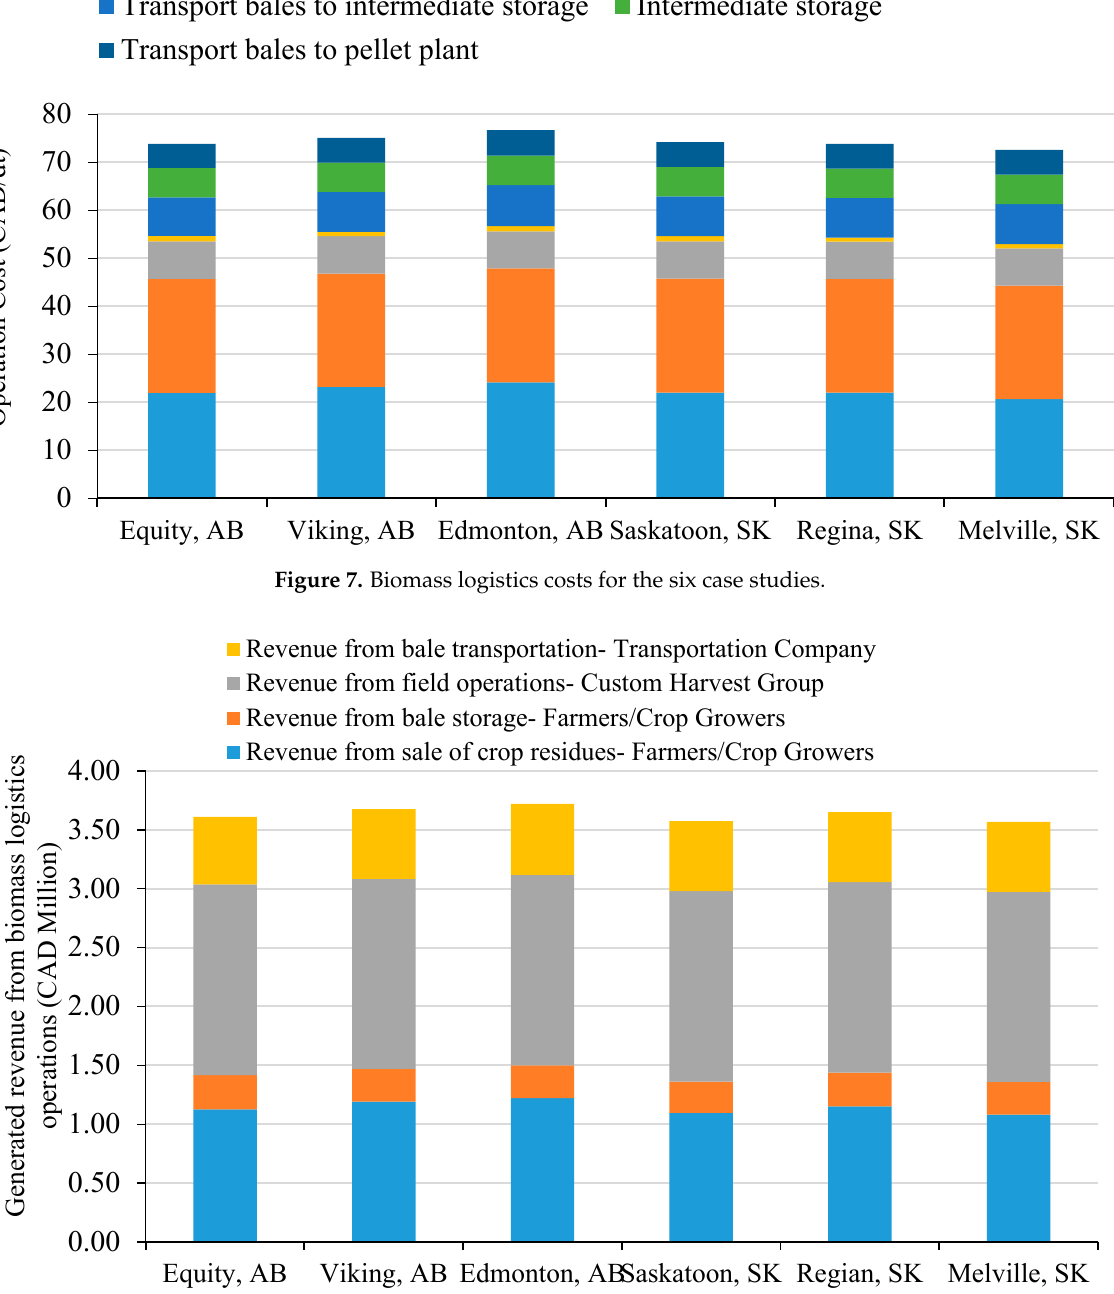
Figure 8. Annual revenue generated in the upstream biomass logistics system by supplying agricultural biomass for the pellet plant.